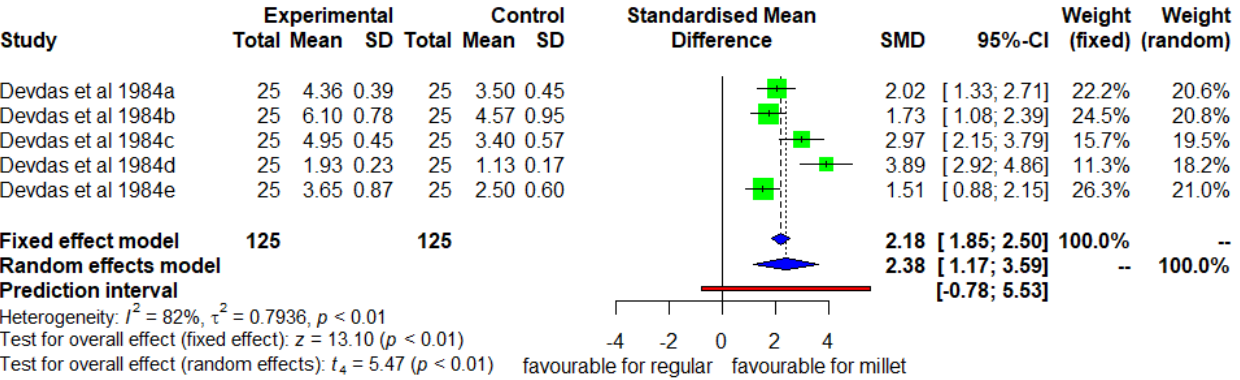
Figure 4. Effect of a consuming finger millet-based diet on mean change in MUAC compared to a regular rice-based diet.